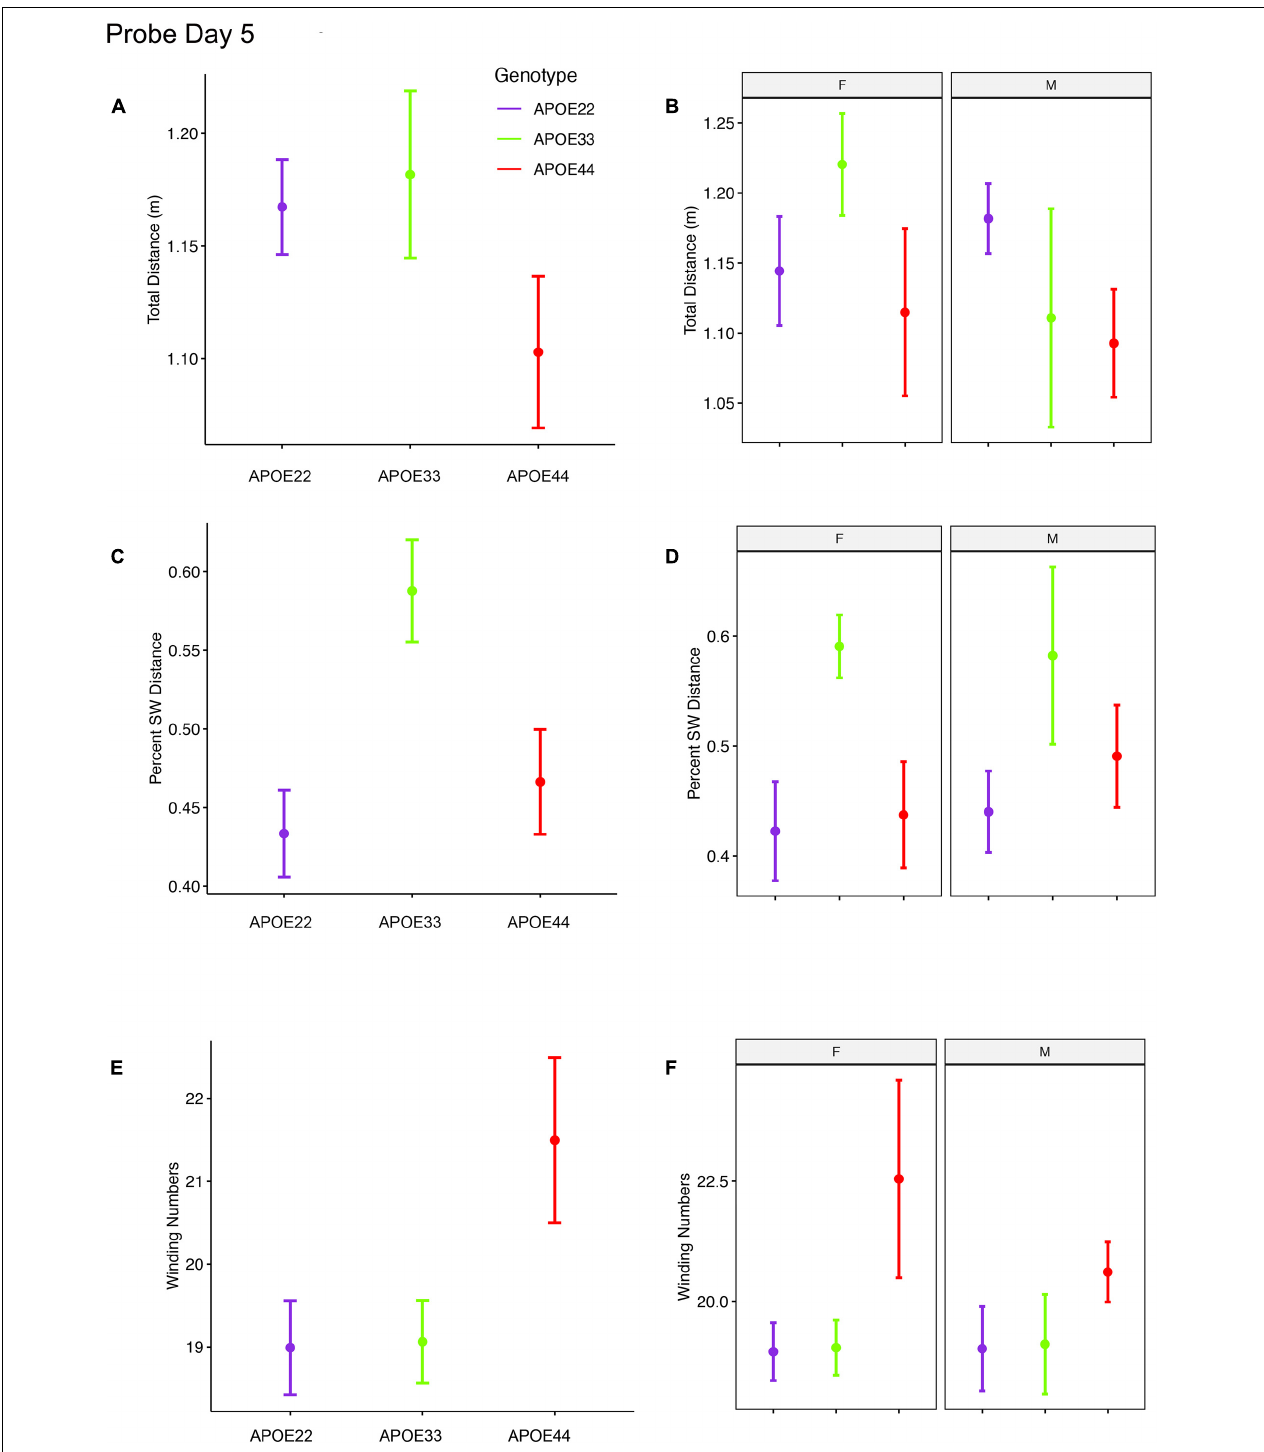
FIGURE 3 | Probe trials 1 hour after ending the learning trials. Long term memory tested one hour after the end of learning trials indicated that APOE4 mice swam less than APOE2 and APOE3 mice, and the data suggested a “dose dependent” genotype effect in males (A,B) . APOE3 mice spent most of their swimming in the target quadrant ( ∼ 80%), while APOE2 and APOE4 mice spent ( ∼ 50%) of their swimming in the target quadrant, but the differences between males and females were not significant (C,D) . APOE2 and APOE4 mice were more similar, while significant differences were noticed between APOE2 and APOE3 mice, as well as between APOE3 and APOE4 female mice. The shape of the swim path, described by the absolute winding number showed similarities between APOE2 and APOE3 mice, but higher loopiness for APOE4 mice (E,F) . These differences were largest for females. F, female; M, male. Graphs show mean ± standard error.